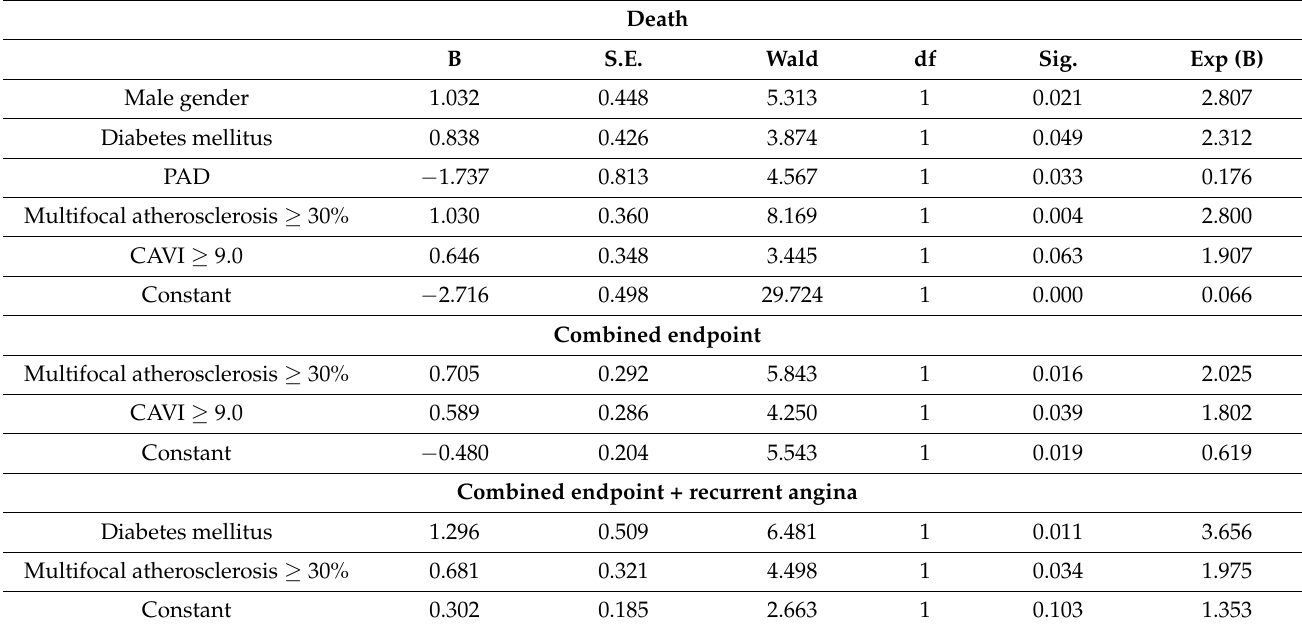
Table 4. Predictors of the unfavorable long-time outcomes after CABG (binary logistic regression analysis, Forward LR method). Death B S.E. Wald df